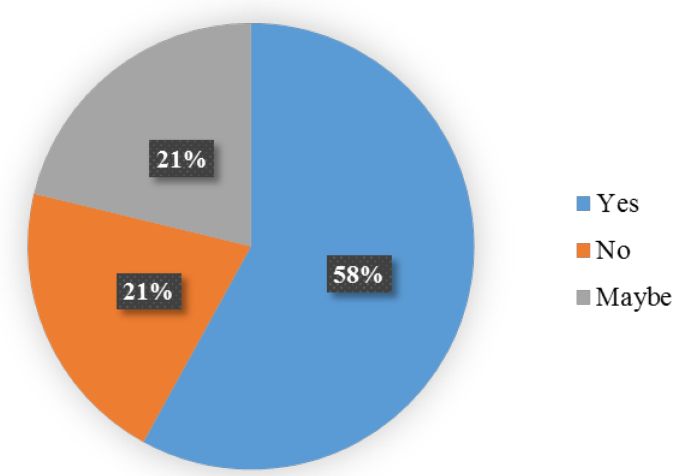
Figure - 11: Showing improvement of academic performance with the initiative of online learning